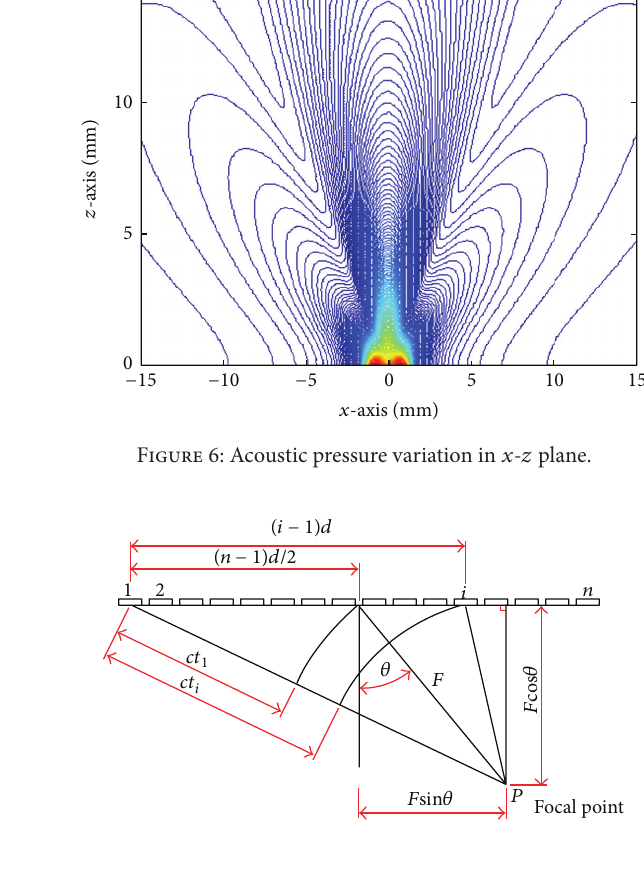
Figure 7: Geometry of linear OPFC phased array for focal point 𝑃